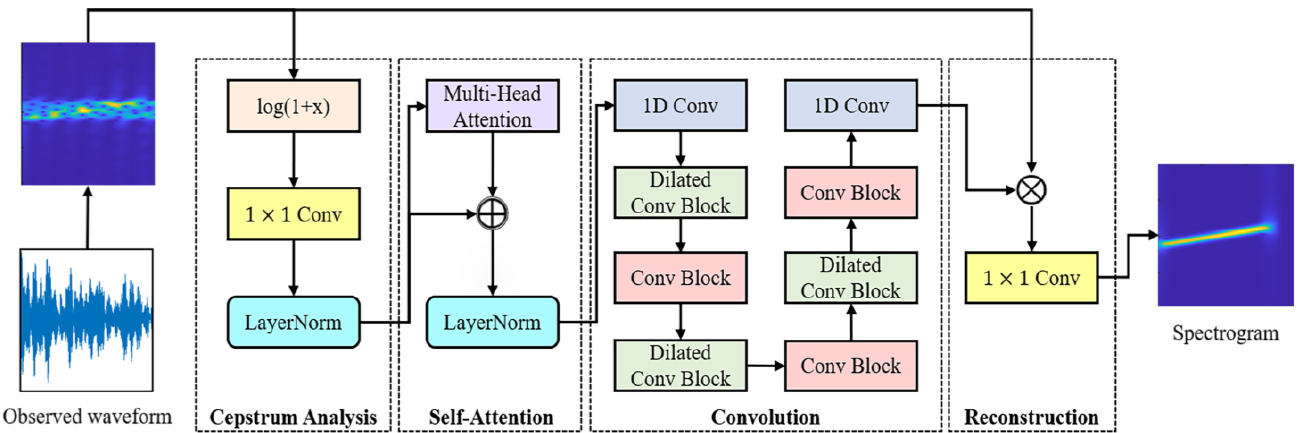
Figure 1. Diagram of the proposed ACANet.